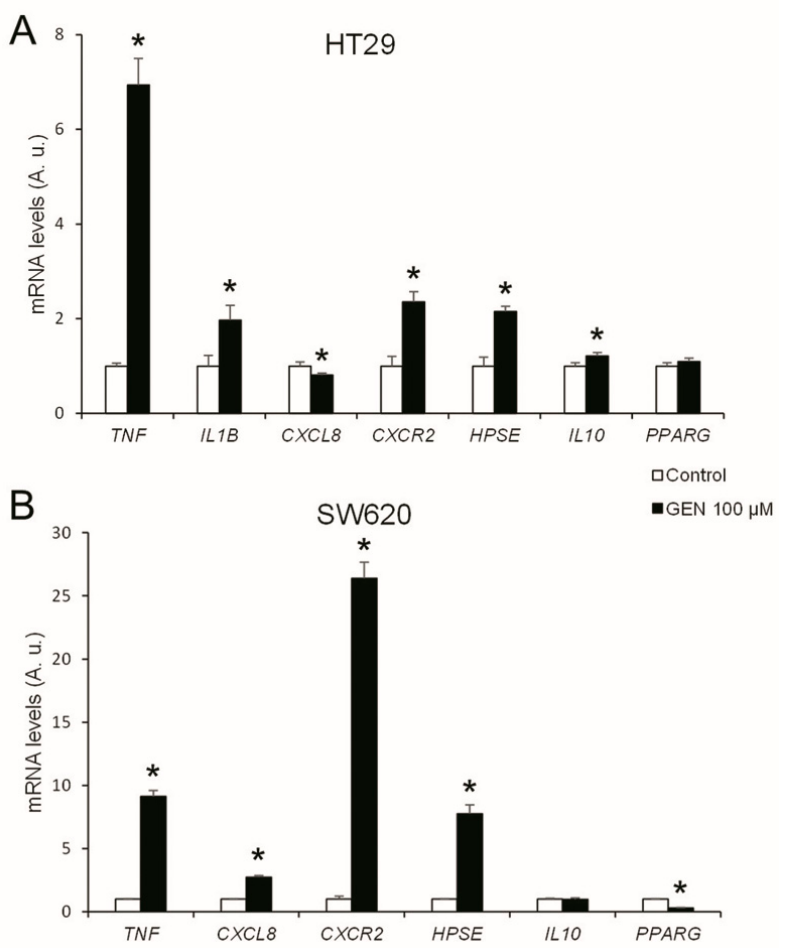
Figure 8. Effects of genistein on mRNA expression levels of inflammation-related genes ( TNF, IL1B, CXCL8, CXCR2, HPSE, IL10 , and PPARG ) in ( A ) HT29 cells and ( B ) SW620 cells determined by real-time PCR. The measurements were made with genistein 100 µ M or 0.1% DMSO (control cells) treatment for 48 h. Values are expressed as mean ± SEM and control values (DMSO-treated cells) were set at 1.00. The coordinate values represent mRNA levels (arbitrary units). GEN, genistein; A.u., arbitrary units. * Significant difference between control cells and genistein-treated cells (Student’s t -test; p < 0.05, n = 6).